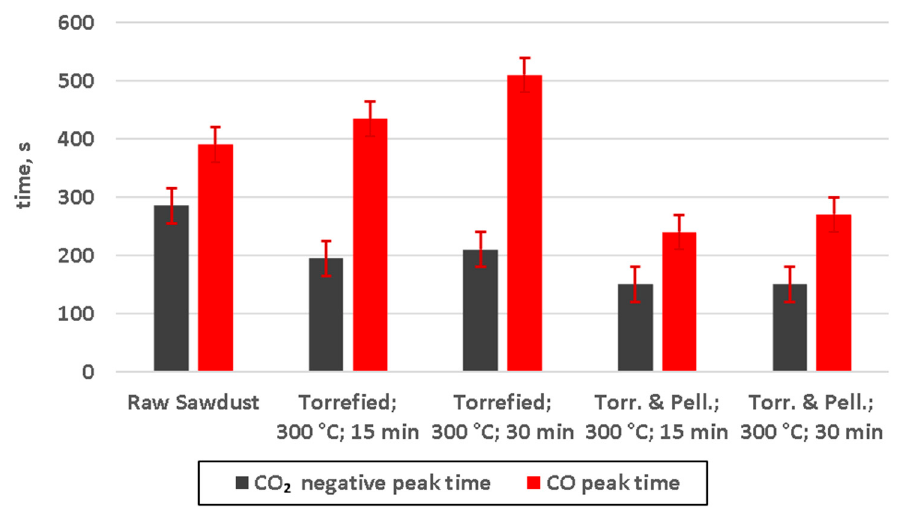
Figure 10. O ff -set between negative peak of CO 2 and peak of CO for performed gasification experiments Figure 10. Off-set between negative peak of CO 2 and peak of CO for performed gasification (Torr. & Pell.—torrefied and experiments (Torr. & Pell. – torrefied and pelletized).